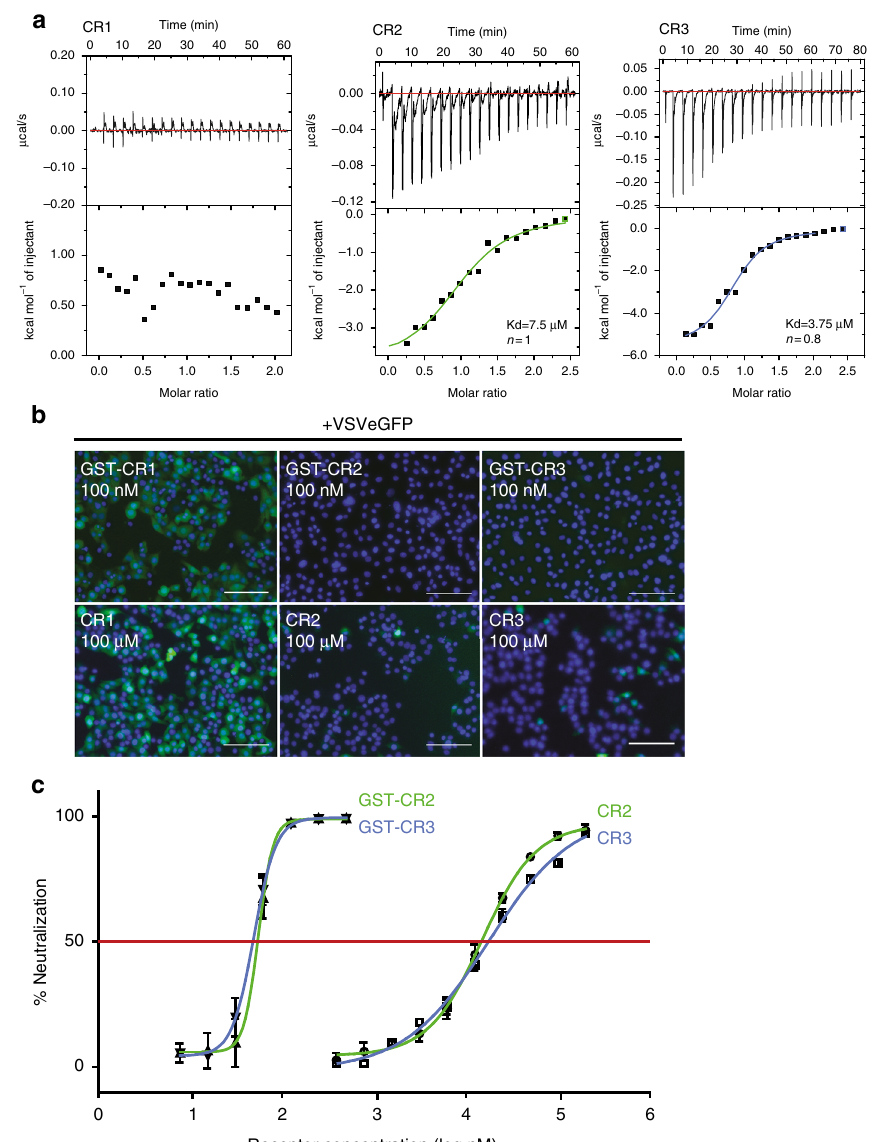
Fig. 2 Characterization of VSV G-CR2 and VSV G-CR3 interaction a Isothermal titration calorimetry (ITC) analysis between G th and CR1, G th and CR2, G th and CR3 at 20 °C. Representative plots of each ITC experiments are illustrated with raw data in the upper panel. Binding parameters were determined by curve fi tting analysis with the single-site binding model. The values indicated in the panel are those corresponding to the curves that are presented. K d values given in the text are means of three independent experiments±standard errors. b , c Inhibition of VSV infection by soluble forms of CR domains. b BSR cells were infected with VSV-eGFP preincubated with GST-CR1, GST-CR2, GST-CR3 (upper part), CR1, CR2, or CR3 monovalent domains (lower part) at the indicated concentrations. Cells were fi xed 4 h p.i. Only infected cells are expressing eGFP. Note that neither CR1 nor GST-CR1 construction protect cells from infection. DAPI was used to stain the nuclei. Scale bars = 100 µ m. c VSV-eGFP was preincubated with increasing concentrations of GST- CR2, GST-CR3, CR2, or CR3 monovalent domains. At 4 h p.i., the percentage of infected cells was determined by counting the number of cells expressing eGFP using a fl ow cytometer. The percentage of neutralization was equal to 100 × [1 − (% of infected cells in presence of CR)/(% of infected cells in the absence of CR domains)]. Data depict the mean with standard error for experiments performed in